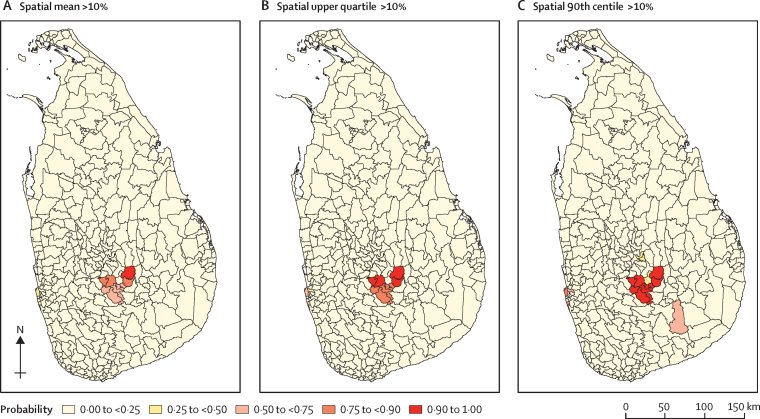
Probability of exceeding soil-transmitted helminth prevalence of 10% at Medical Officer of Health levelProbability of exceeding soil-transmitted helminth prevalence of 10% for spatial mean (A), spatial upper quartile (B), and spatial 90th centile (C).